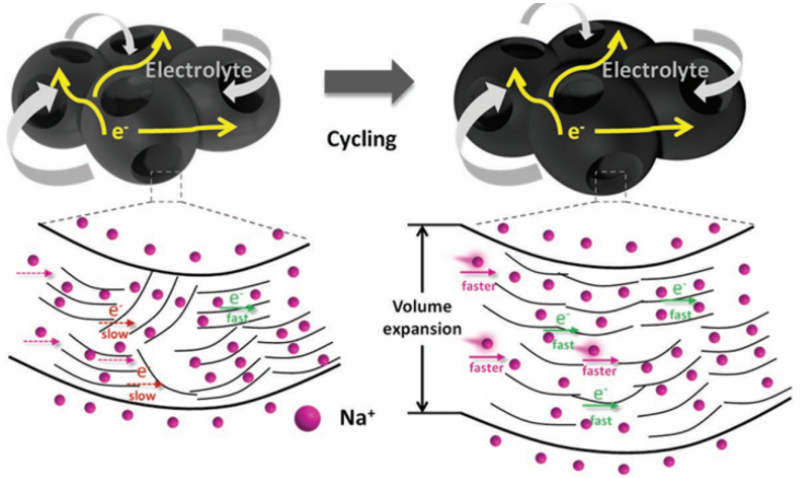
Figure 12. Schematic illustration of the heteroatom-doped mesoporous hollow carbon spheres, whose structure can also maintain stable and expanded Sodium-ion transport after volume expansion [103].